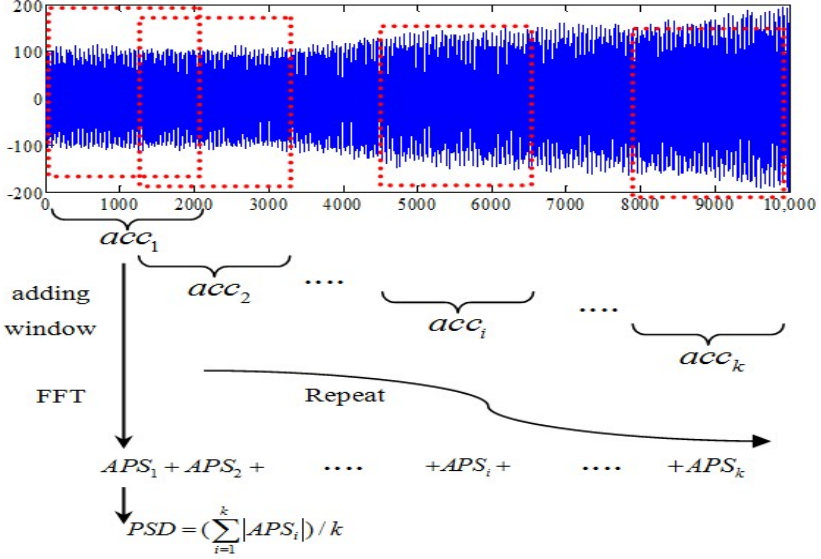
Figure 4. Procedure of fully automated PSD calculation.